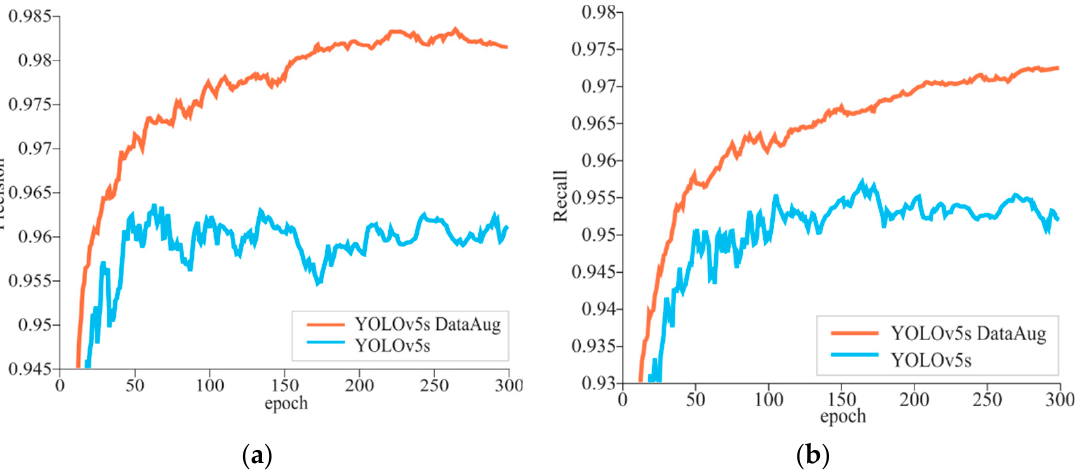
Figure 5. Precision and recall for the YOLOv5s detection model. ( a ) Precision, ( b ) Recall.